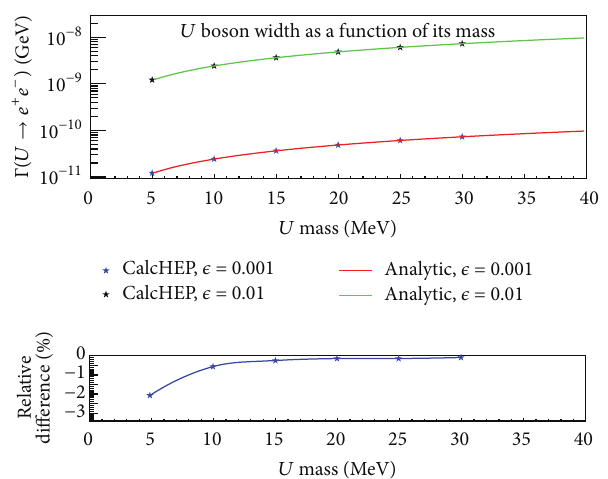
Figure 1: 𝑈 boson width calculated with formula (3) and compared to the toy model implemented in CalcHEP. Matching between the different calculations is better than